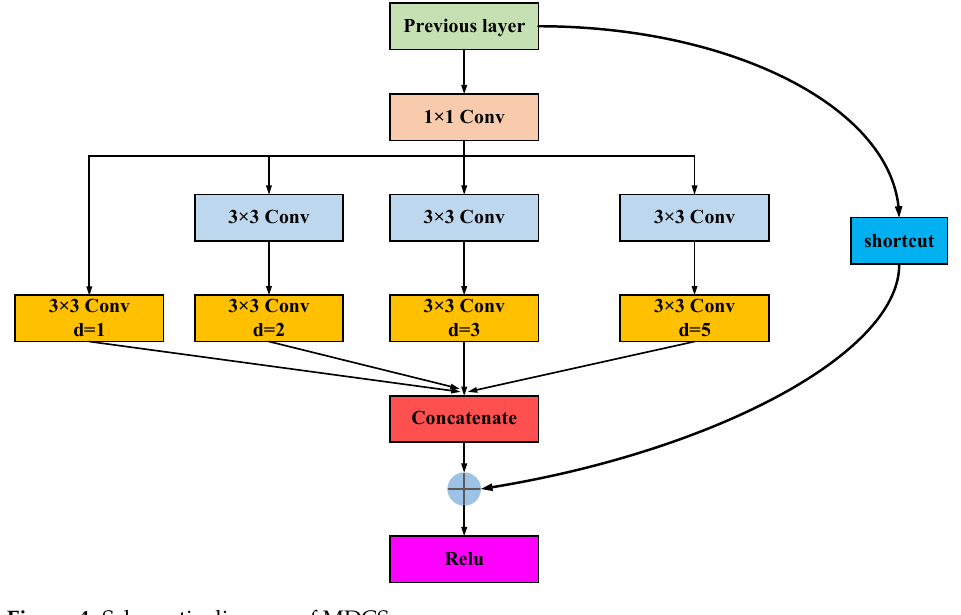
Figure 4. Schematic diagram of MDCS.